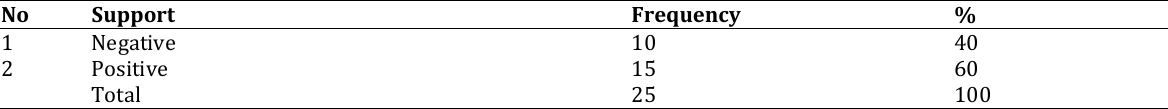
Table 1. Family support